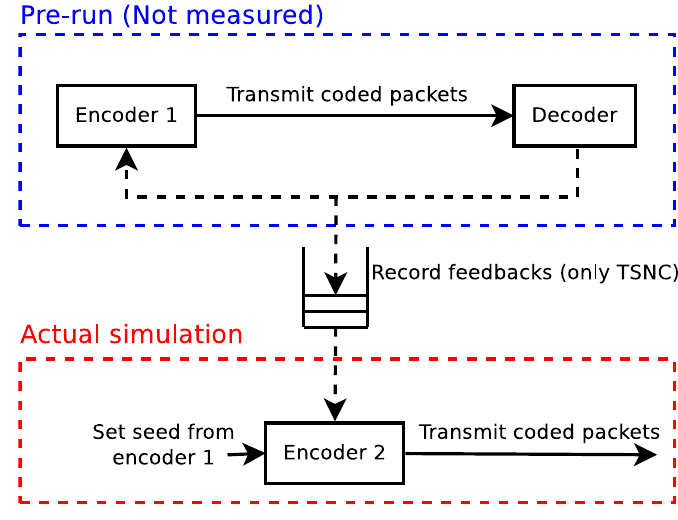
Figure 1. Encoding goodput